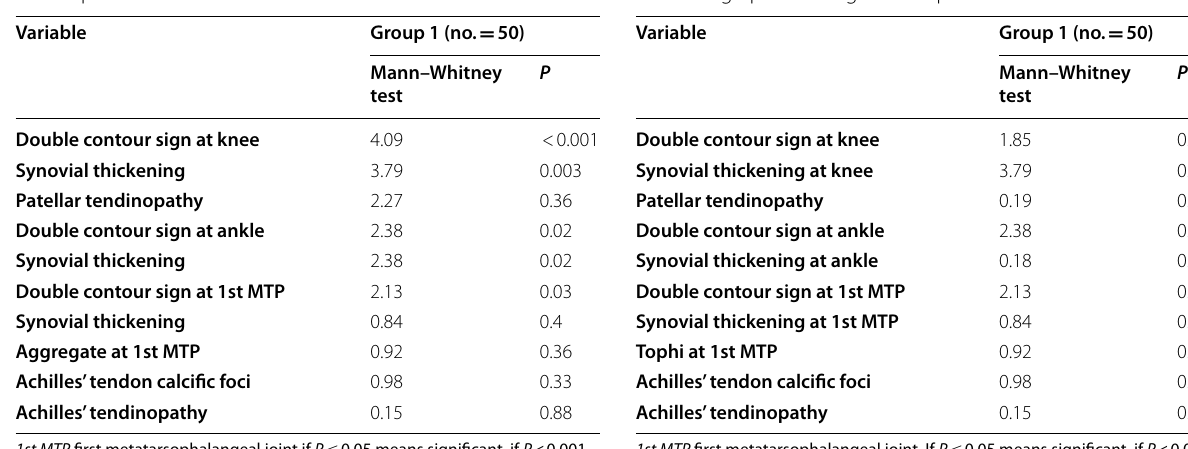
Table 2 Relation between CMP with ultrasonographic findings in CKD